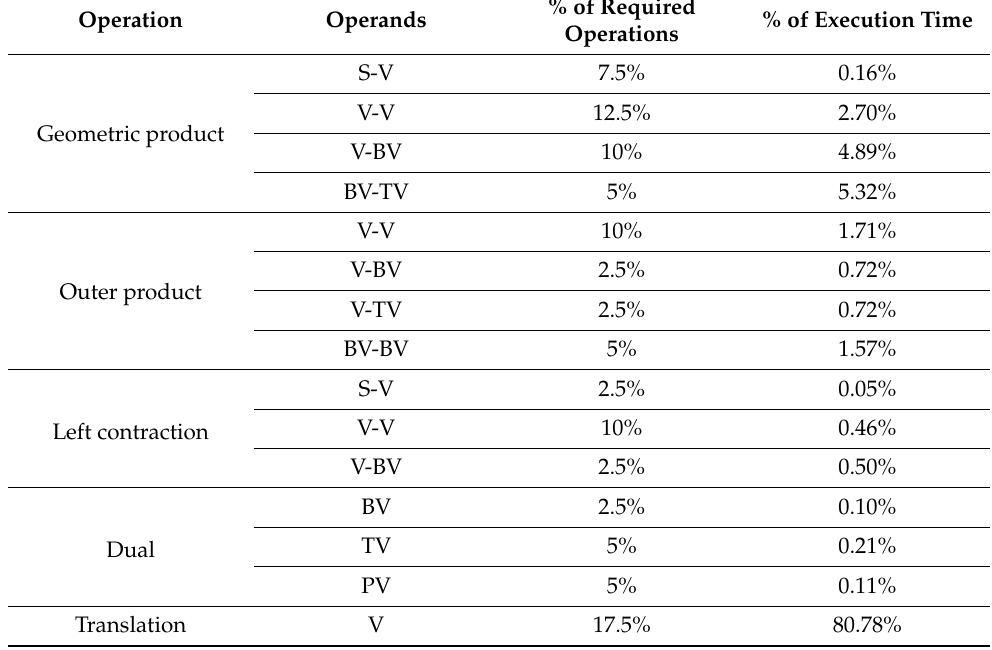
Table 10. Inverse kinematics algorithm profiling.